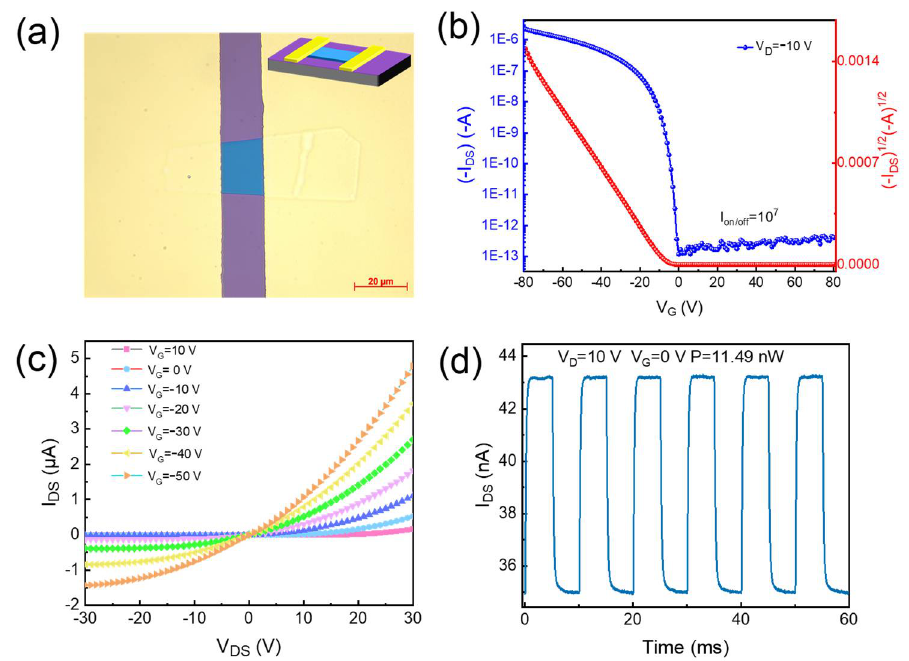
Figure 5. ( a ) Optical image of nanosheet crystal based on OFETs. (L = 15 μm, W = 19 μm.) Inset shows a schematic of the device’s configuration. The representative ( b ) transfer curves and ( c ) output curves of OFET based on nanosheet crystal. ( d ) Time-dependent photoresponse of the device under 658 nm illumination (V DS = 10 V, V G = 0 V).